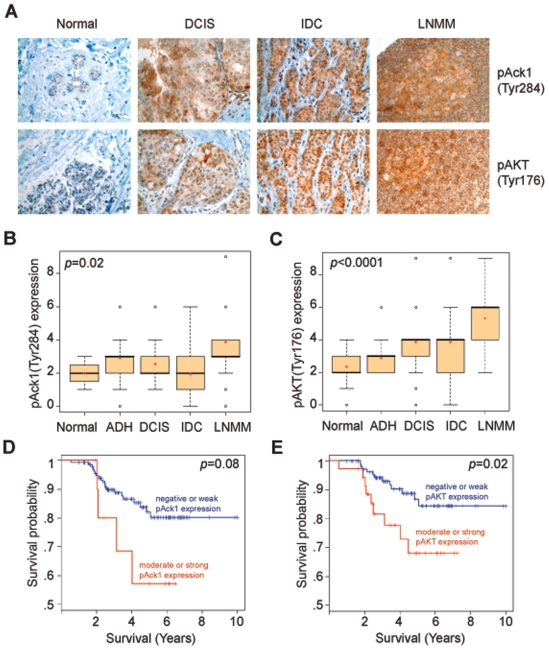
pTyr284-Ack1 and pTyr176-AKT expression in breast cancer.(A) TMA sections representing different breast cancer stages stained with pTyr284-Ack1 and pTyr176-AKT antibodies. (B) Box plots to summarize distributions of staining intensities for pTyr284-Ack1 in different stages of breast cancer. A significant increasing trend of intensity across progression stages was detected (Mantel-Haenszel  test, p = 0.02). The box has lines at the lower quartile (25%), median (50%), and upper quartile values (75%) while the red-cross within the circle marks the mean value. Whiskers extend from each end of the box to the most extreme values within 1.5 times the interquartile range from the ends of the box. The data with values beyond the ends of the whiskers, displayed with black circles, are potential outliers. (C) Box plots to summarize distributions of staining intensities for pTyr176-AKT in different stages of breast cancer. A significant increasing trend of intensity across progression stages was detected (Mantel-Haenszel  test, p<0.0001). (D) Kaplan–Meier analysis shows that individuals with breast cancer that have moderate to strong staining (>4) of pTyr284-Ack1 have a lower probability of survival (log rank test, p = 0.08). (E) Kaplan–Meier analysis of the breast cancer patients that have moderate to strong staining (>4) of pTyr176-AKT have significantly lower probability of survival (log rank test, p = 0.02).